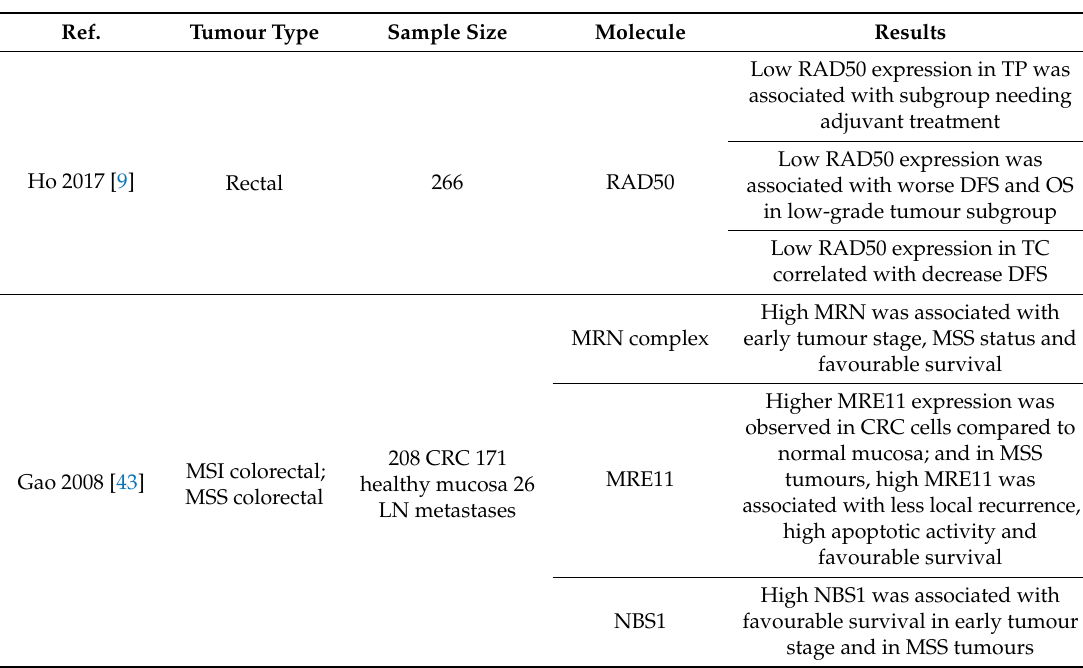
Summary of correlation between high MRN complex expression and favourable clinicopathological outcomes in colorectal cancer.